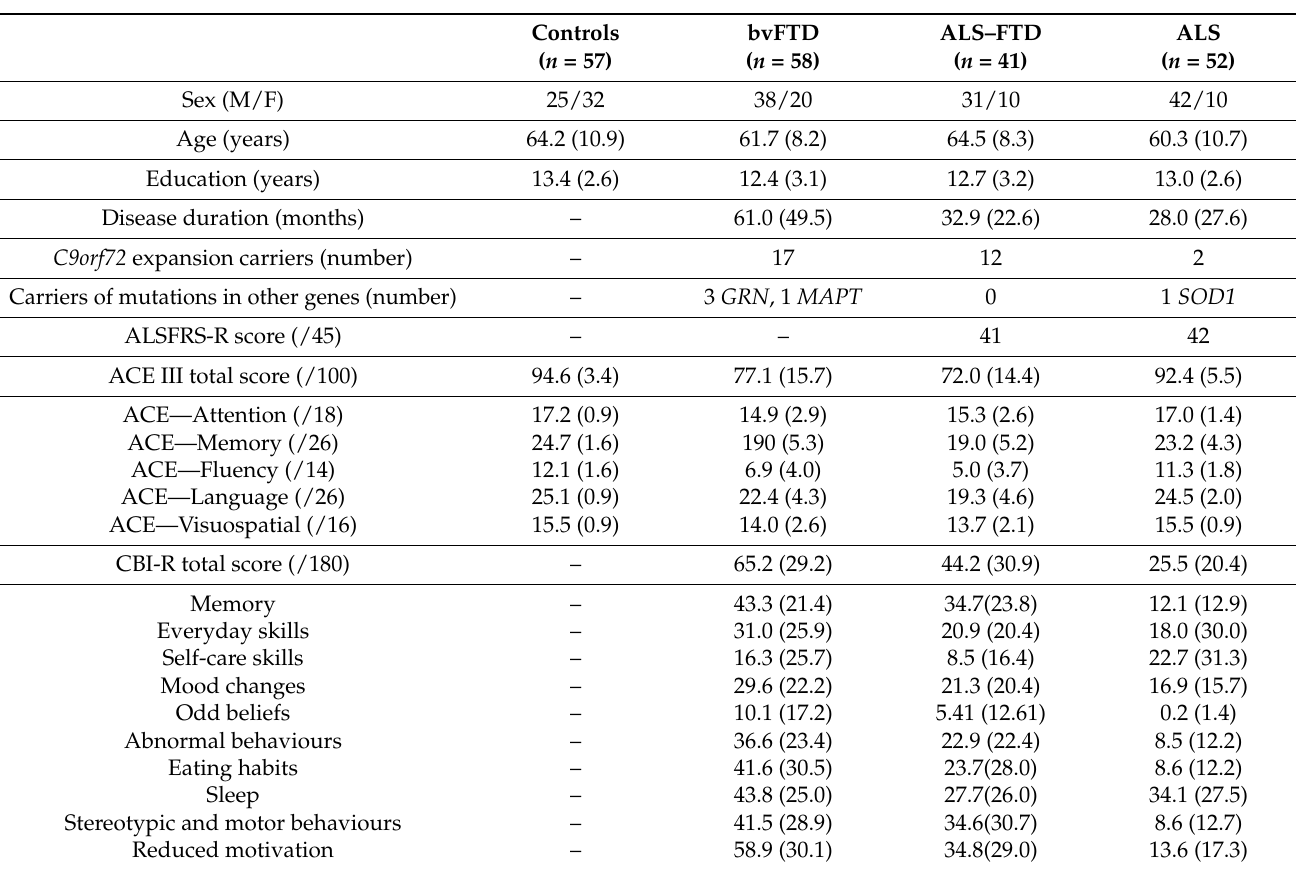
Table 1. Demographic characteristics of study participants. Values denote means and